Question: What does this figure show? Answer in one sentence.
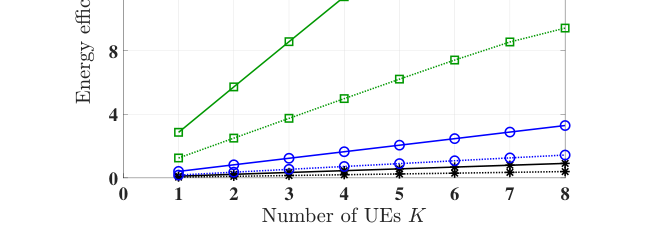
Answer: Comparison of the energy efficiency versus the number of UEs for various beamforming schemes.